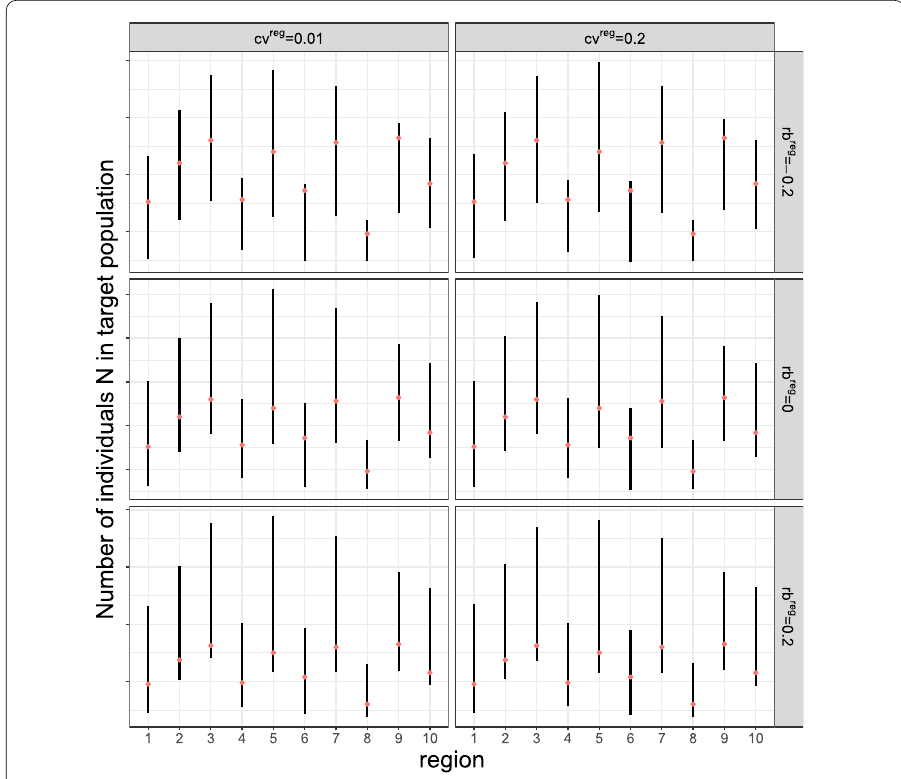
Figure 17 Credible intervals for the initial number of individuals N 0 per region. Credible intervals (prob = 95%) for the initial number of individuals N 0 per region compared to true values (in red) computed according to the whole module integration using the RSS geolocation model with uniform prior and the beta negative binomial inference model. See animated gif N_CI_bnb_t.gif in [50] for the full time sequence of credible intervals and different values of rb reg and cv